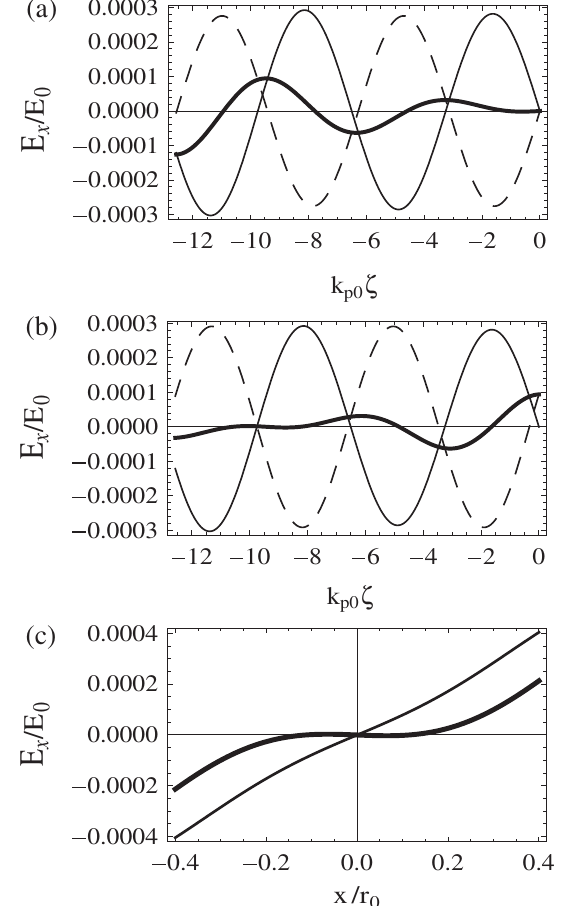
FIG. 6. Transverse electric field, at x=r 0 ¼ 0 : 1 . (a) The field from the Gaussian ( a 0 ¼ 0 : 1 ) only (dashed line) is shown as well as the field from the first-order Hermite-Gaussian mode ( a 1 ¼ ffiffiffi p 2 a 0 = ) only (dotted line), and the sum (solid line). (b) The field from the Gaussian ( a 0 ¼ 0 : 1 ) only (dashed line) is shown as well as the field from the first-order Hermite-Gaussian mode (dotted ¼ 0 : 33 ( a ¼ 0 : 73 a (cid:4) line) shifted by k 1 0 ) such that the sum p 0 s ¼ (cid:3) 9 : 75 . (c) Sum of the Gaussian (cid:4) (solid line) is ’ 0 , given k p 0 o and the first-order Hermite-Gaussian modes transversely at (cid:4) ¼ (cid:3) 9 , with a 0 ¼ 0 : 1 and a 1 ¼ 0 : 73 a 0 , when the peaks k p 0 of the two modes are aligned (thin line) and when the higher- ¼ 0 : 33 (thick (cid:4) order mode is shifted by k p s